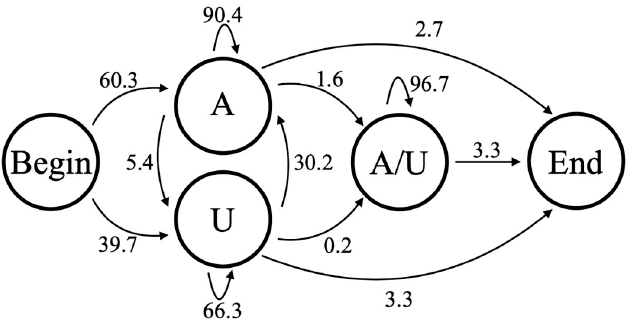
Fig 9. Model B3. 3-state model of nontemplated tail addition (B3), with state transition percentages from the model trained on combined CO1P, ND1B, and ND1P experimentally-derived Illumina sequenced tail data.